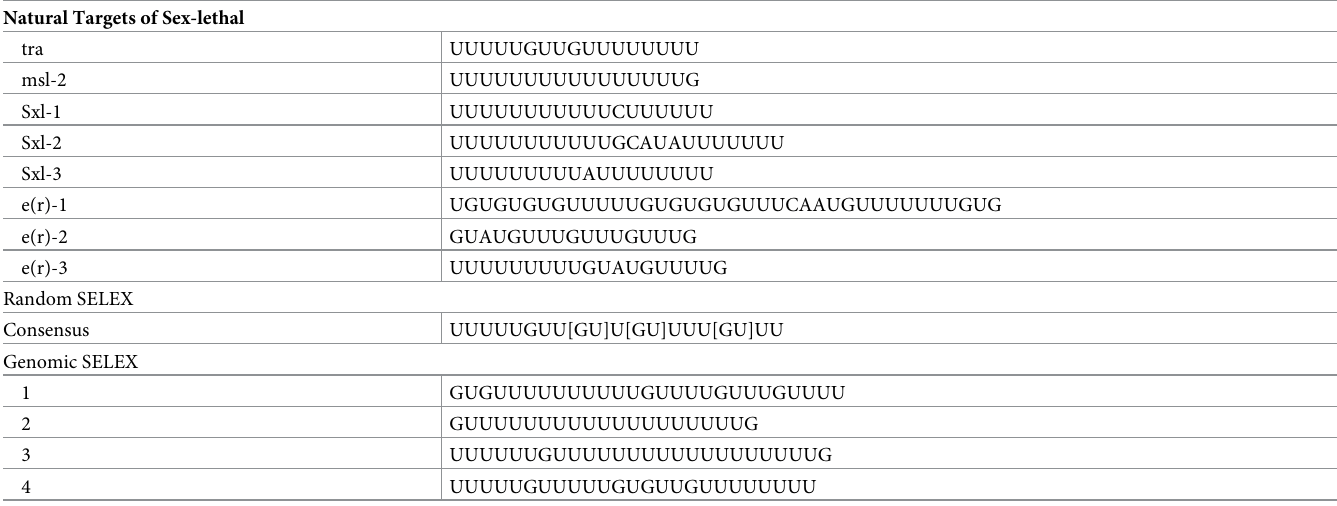
Table 1. Sequences of the SXL-binding sites from the genomic library.